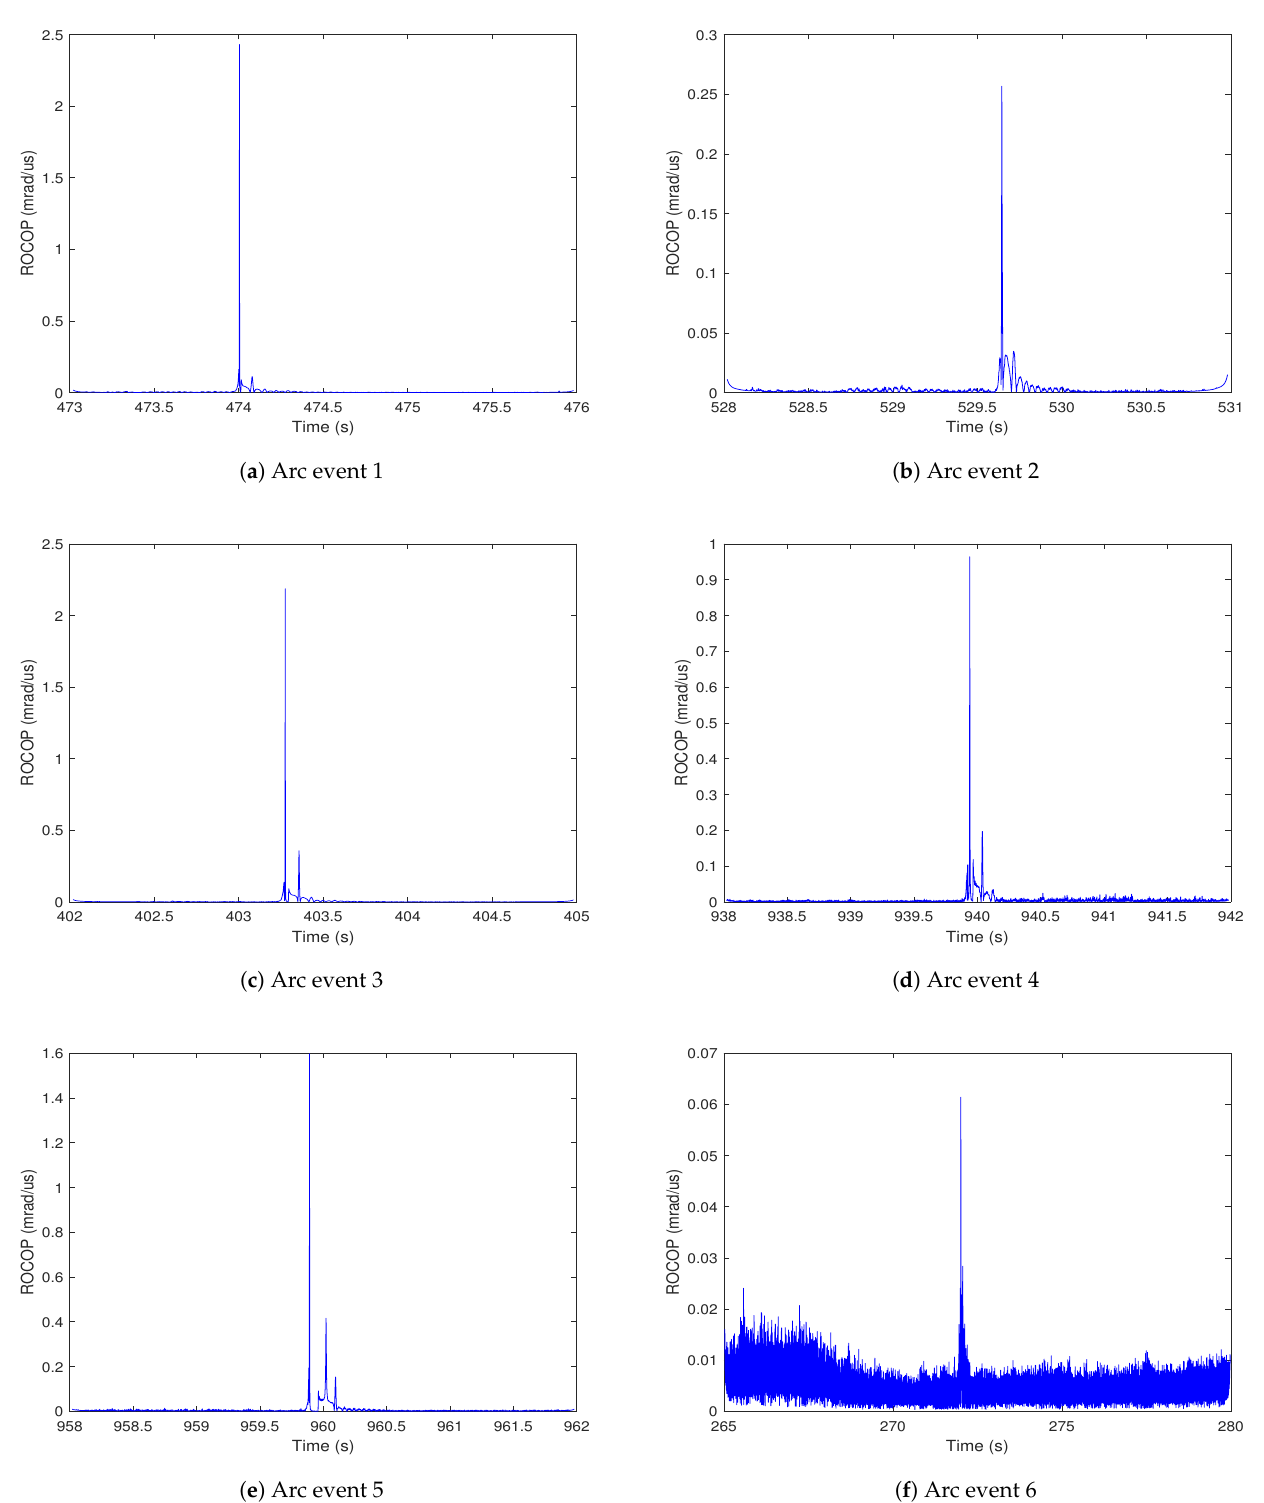
Figure 13. Absolute instantaneous ROCOP after being filtered by the MA filter for the arc events 1 to